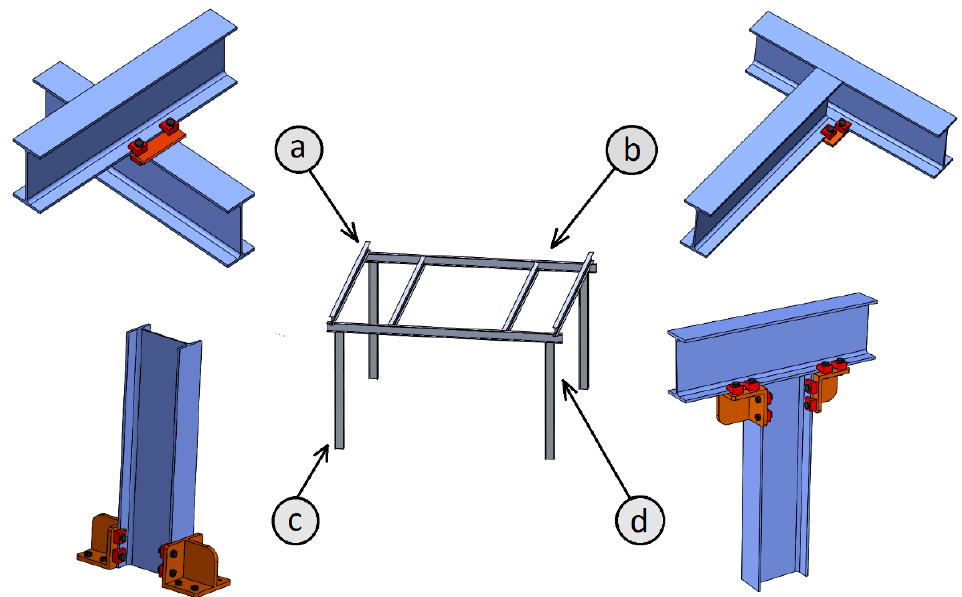
Figure 2. Some examples of joints with clamps: ( a ) cross union between beams; ( b ) union between beam end and beam web; ( c ) removable base system for I-section pillars; ( d ) union of end beam and pillar at 90º.